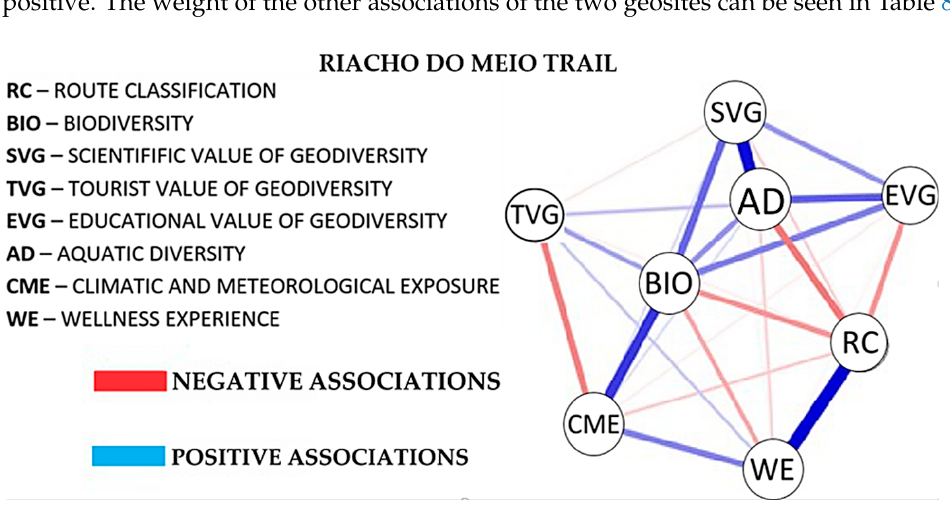
Figure 16. Network Ecosystem’s Health Provision Spectrum of the Riacho do Meio trail.